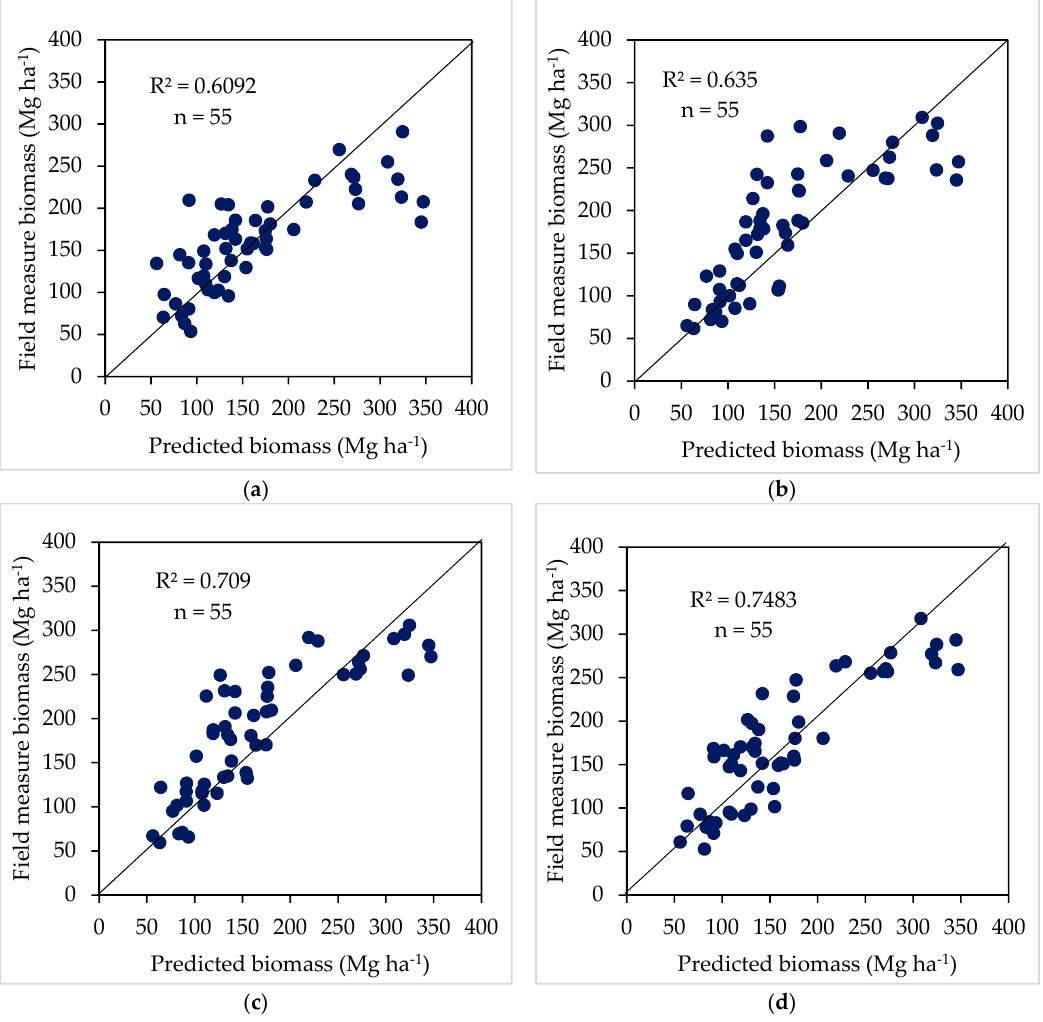
Figure 4. The validation results for different models: ( a ) Model 5, ( b ) Model 6, ( c ) Model 7, and ( d ) Model 8. The 1:1 cross plots between the predicted and ground data are shown.